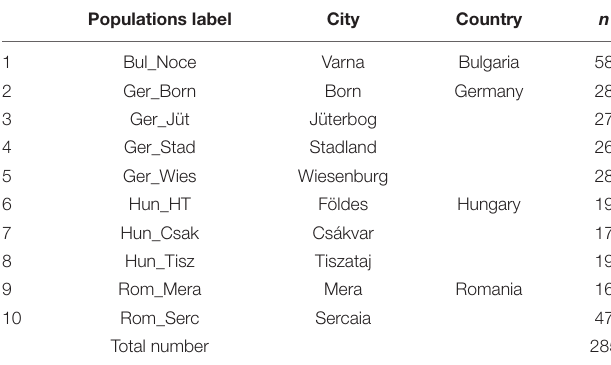
TABLE 1 | River buffalo populations analyzed in the present study (n: samples per